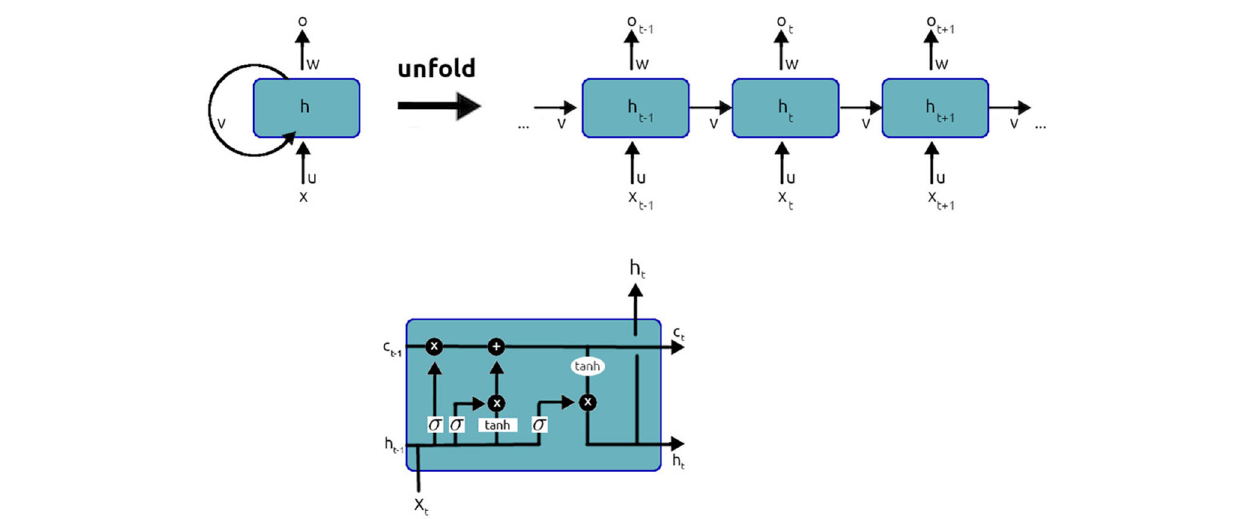
FIGURE 1 | LSTM networks are capable of keeping track of long-term dependencies. As recurrent neural networks (upper layer of the figure), they present a chain-like structure: at each time step t, the network’s output is computed based on both the input of time t ( x t ) and the network’s state at time t − 1( h t − 1 ). As opposed to a simple recurrent cell, an LSTM cell (lower layer of the figure) has the ability to regulate how the two kinds of information (input and previous state) are weighted towards the computation of the output. The first gate, the forget gate, evaluates C t − 1 (a representation of the previous state different from h t − 1 ) against x t and learns what information to keep from previous steps, including it in a vector f t . Next, a candidate value for the current state ˆ C t is computed along with the input gate vector i t that weighs how much of the input will contribute to the current state. Finally, the state of the cell C t is computed by weighting C t − 1 with the forget gate vector f t and the at ˆ C t with the input vector i t . h t is then computed from C t . A complete and easy to read guide to LSTMs can be found at https://colah.github.io/posts/2015-08-